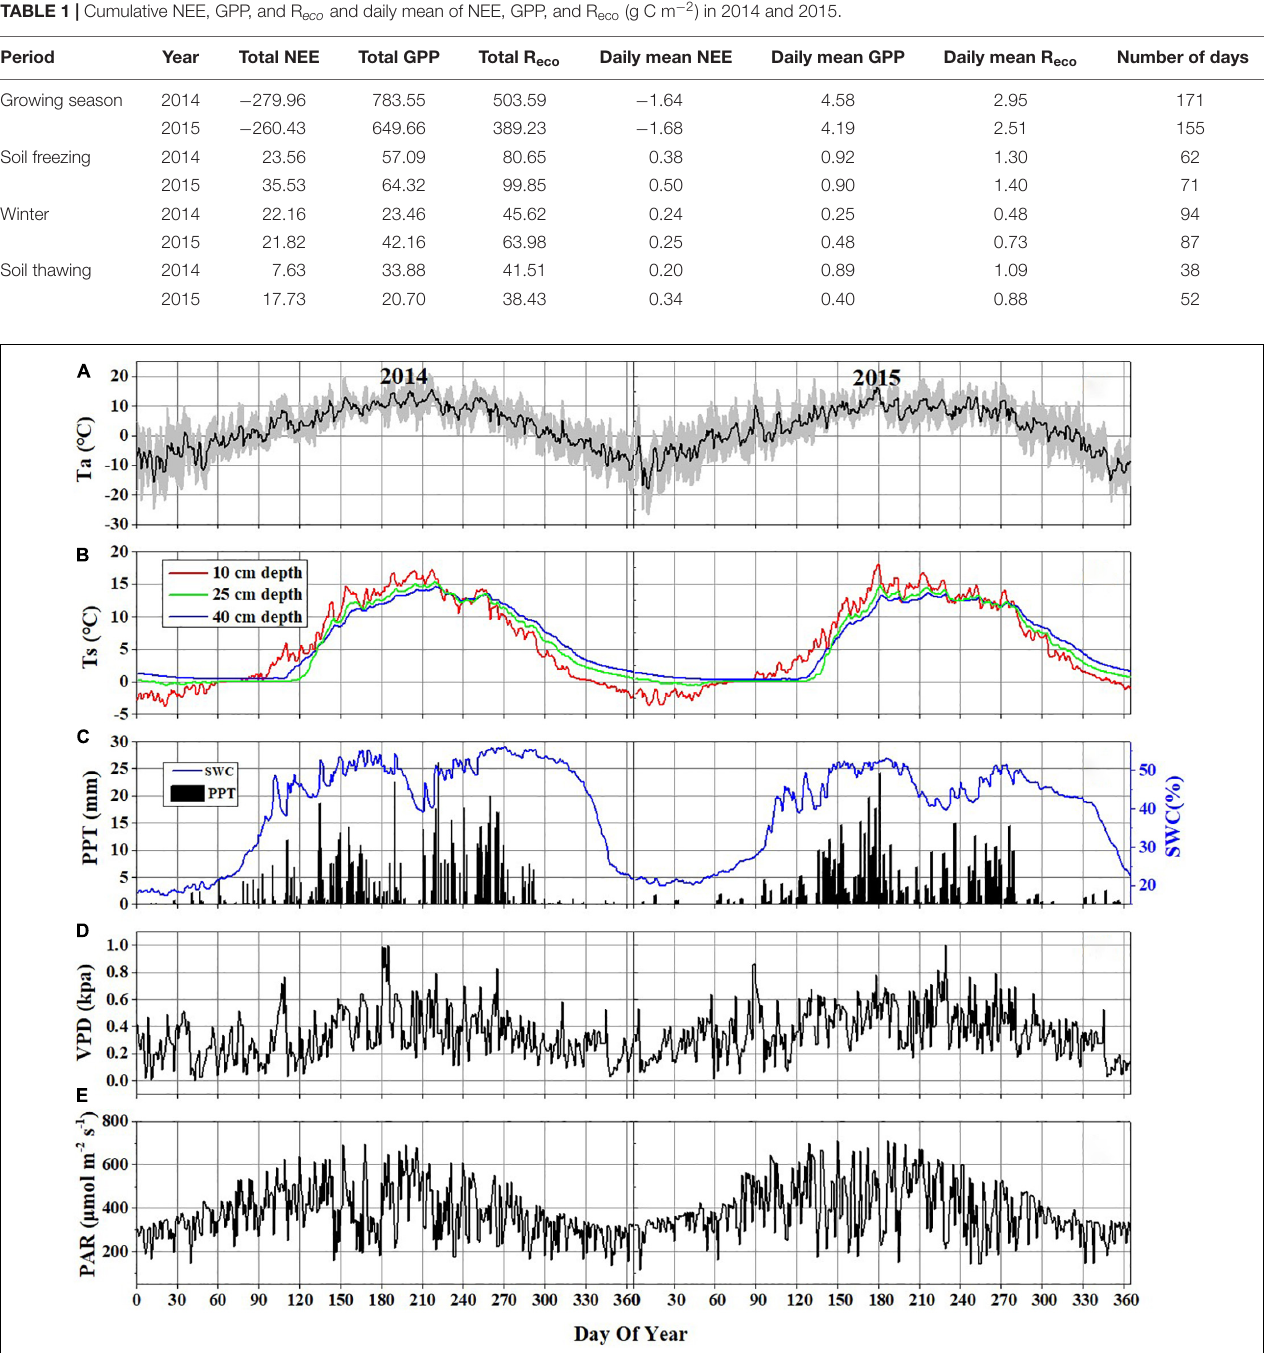
FIGURE 2 | Daily variations of major environmental variables in 2014 and 2015: (A) air temperature (Ta) at 2 m above the ground (the black line represents daily means and the shaded area denotes standard deviation for each half-hour interval); (B) soil temperature (Ts) at 10 cm (blue line), 25 cm (green line), and 40 cm (red line) below the ground; (C) daily precipitation (PPT) and daily mean soil water content (SWC) at 10 cm depth below the ground; (D) daily mean VPD; (E) daily mean